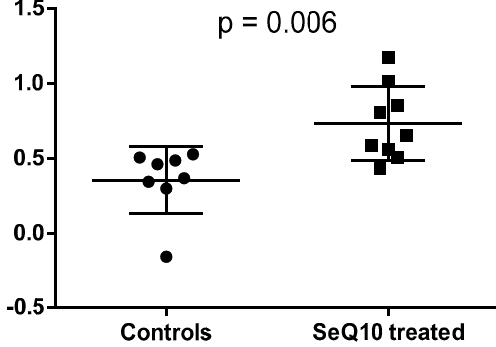
Figure 2. Predicted cross-validated Y values (from the OPLS-DA model). Note: Actual values for controls are denoted 0 and for SeQ 10 -treated are denoted 1, showing that the two groups’ metabolic patterns are significantly different ( p = 0.006).